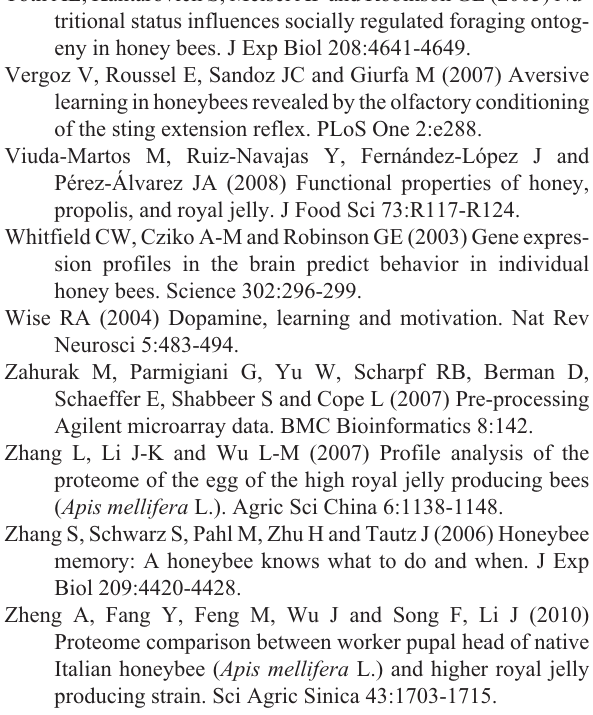
Table S1 - The details of probes in microarray construction. Table S2 - Standardized data of high and low royal jelly bees. Table S3 - Primer sequences of the detected genes. Table S4 - Information of 369 differentially expressed genes screened by gene chip. Table S5 - KEGG analysis of the differently expressed